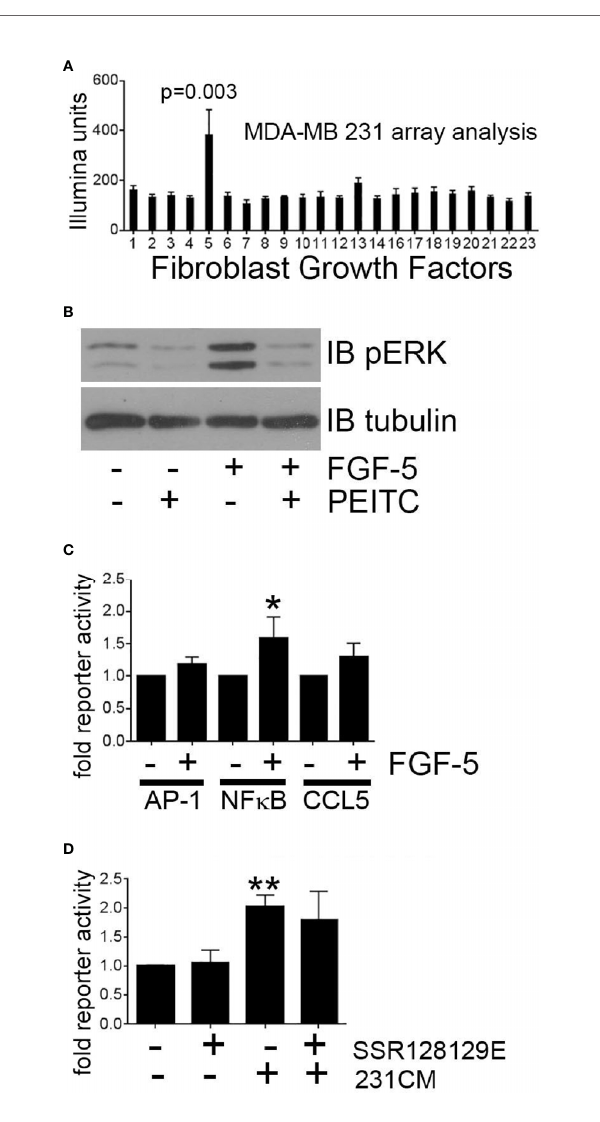
FIGURE 6 | Breast tumor cell-derived FGF-5 activates MEKK1 in mammary fi broblasts. Analysis of MEKK1 signaling induced by MDA-MB 231-derived FGF-5. (A) Graphical representation of relative expression of FGF genes expressed in cultured MDA-MB 231 cells as detected by Illumina expression array analysis. X axis label indicates FGF family member assigned to each column (column 5 = FGF-5). (B) Phospho-ERK1/2 MAPK immunoblot analysis of lysates extracted from mammary fi broblast pre-treated for 1 h with vehicle or PEITC (0.3 µM) prior to stimulation with FGF-5 (25 ng/ml). An anti- tubulin immunoblot is displayed as a loading control. (C) Luciferase reporter analysis of mammary fi broblasts transfected with reporter plasmids wherein luciferase expression is driven by either the CCL5 promoter or response elements that bind AP-1 or NF k B. (D) CCL5 reporter analysis of mammary fi broblasts treated with FGFR1 inhibitor SSR128129E (0.3 µM) prior to an 8 h stimulation with culture media conditioned by MDA-MB 231 cells (231CM). The data represented in graphs are derived from three independent experiments. *p < 0.05, **p < 0.01 against control by